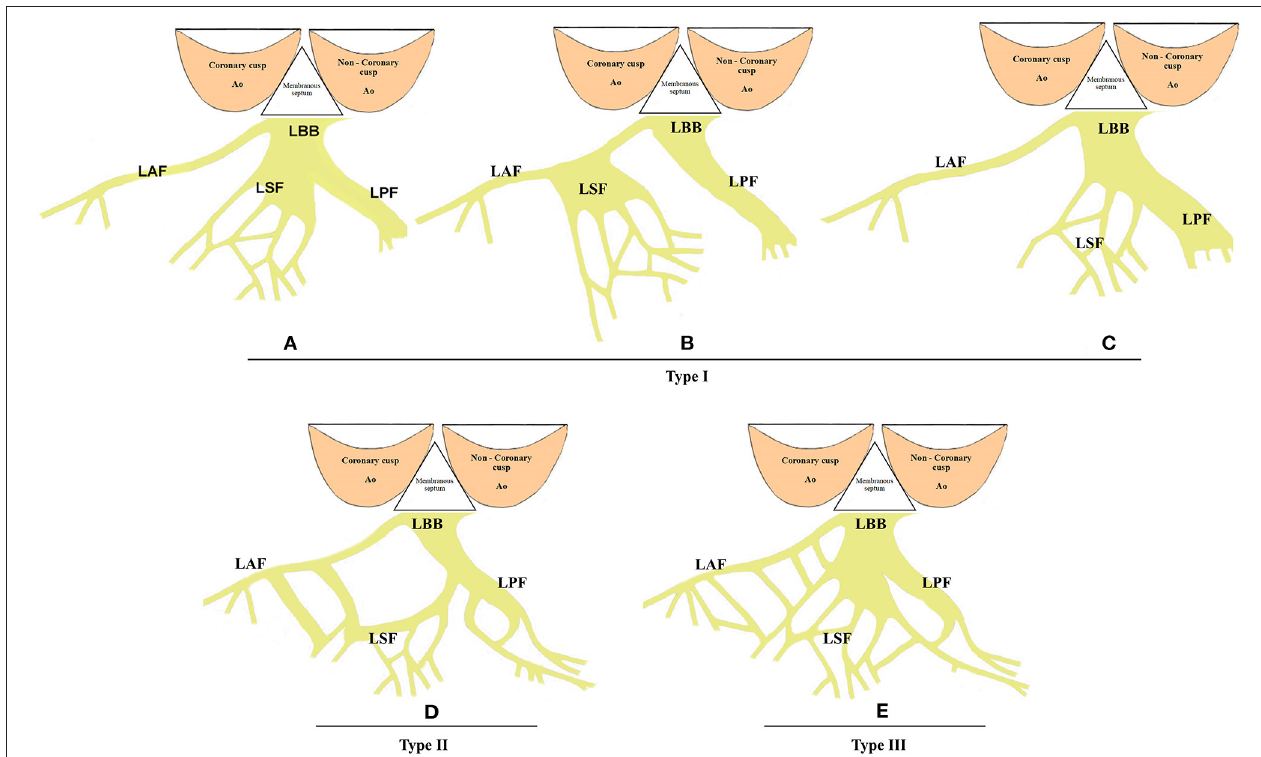
FIGURE 2 | The anatomical variants of LSF. (A–C) The most common LSF pattern, known as type I. In this type, LSF may originate from the main LBB or any of its division (PD or AD). (D) Type II anatomical variants of LSF. The LSF branches concomitantly from the AD and PD. (E) In type III, LSF is a “fan-like interconnecting network.” LSF, left septal fascicle; LBB, left bundle branch; AD, anterior division; PD, posterior